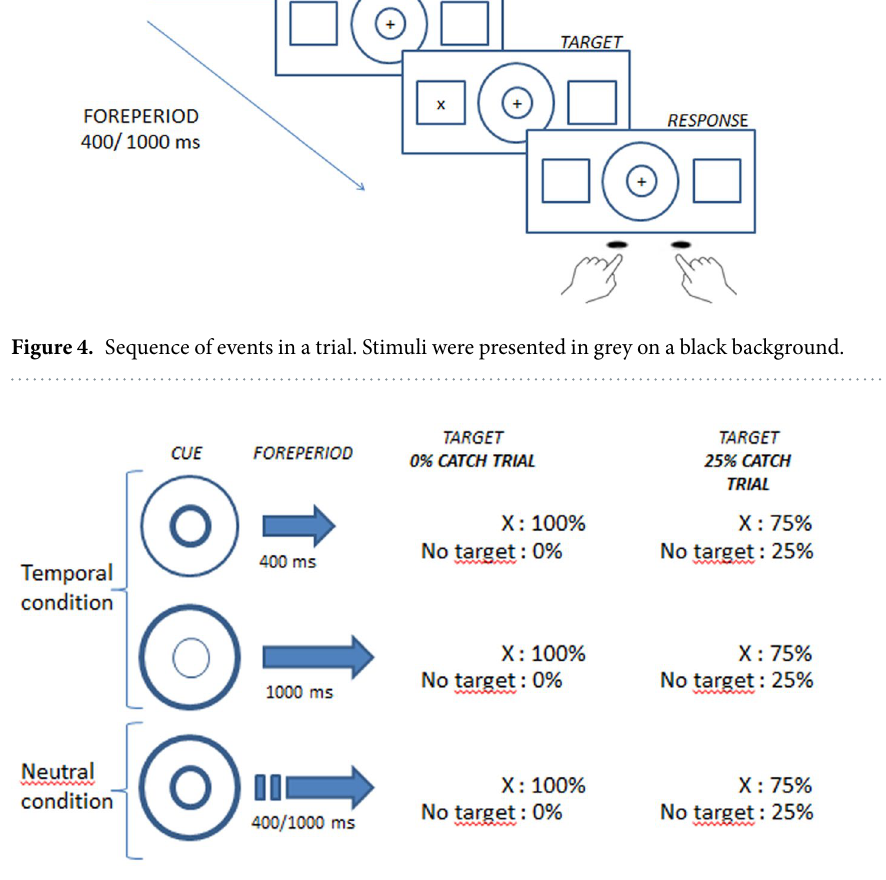
Figure 5. Experimental conditions. In the temporal condition, cues indicated that the target would appear after either a short (top row) or long (middle row) foreperiod. In the neutral condition (bottom row) cues provided no temporal information and the target was equally likely to appear after a short or long foreperiod. Targets were either present on every trial (“without catch trials” condition) or were absent on 25% of trials in the block (“with catch trials”